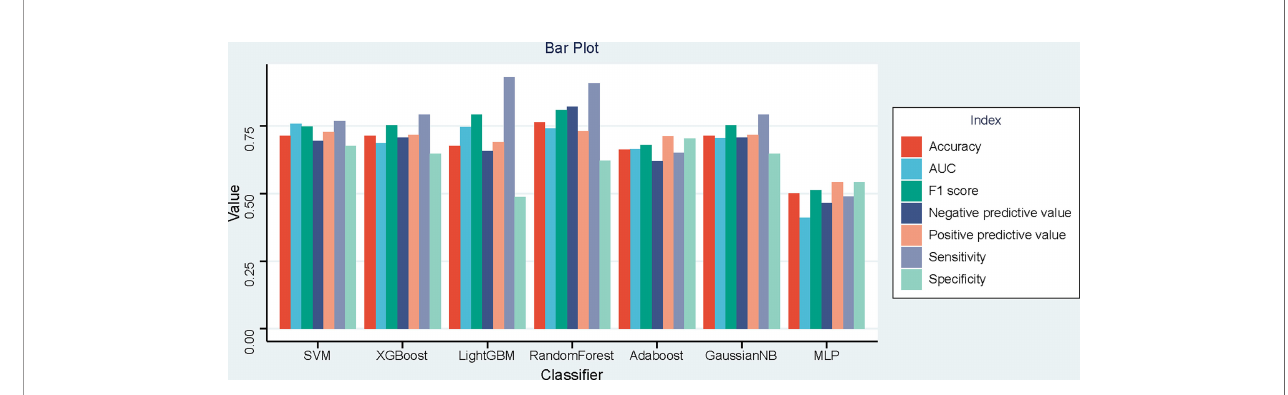
FIGURE 3 | Bar plot of the seven models ’ performances in the time-independent external validation based on least absolute shrinkage and selection operator